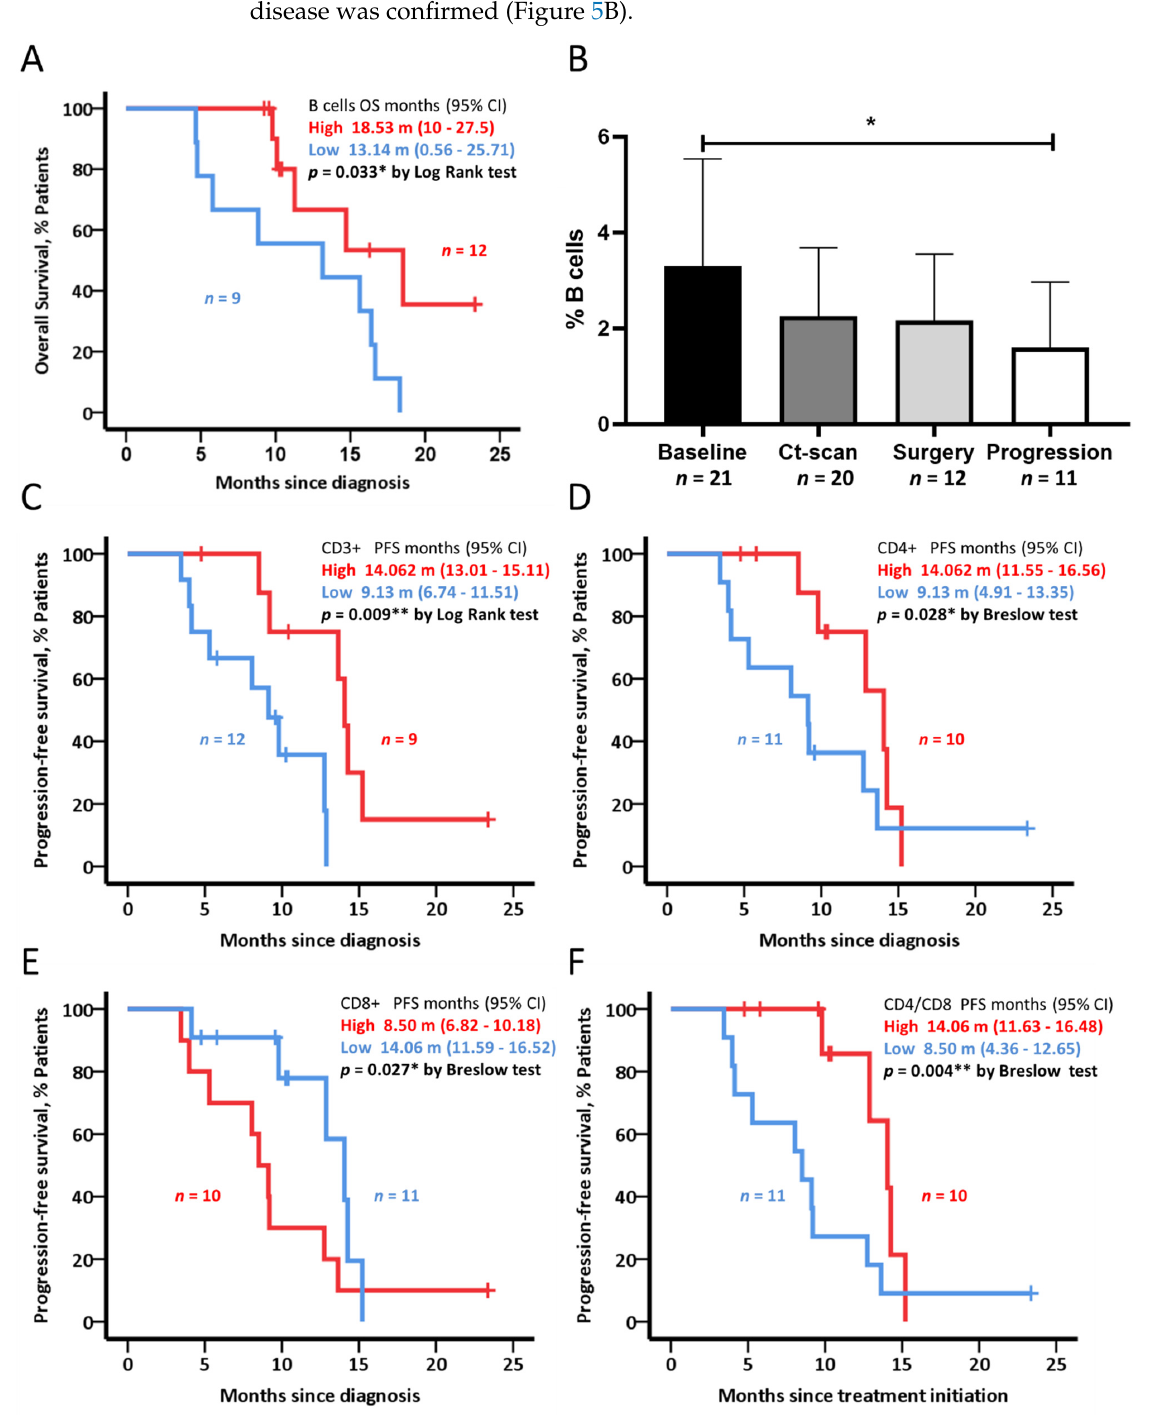
(Figure 5F). Density plot graphs of B cell and CD4+/CD8+ T cells frequencies comparing patients with favorable and unfavorable outcome showed differences at first sight (Sup- plementary Figure S3).